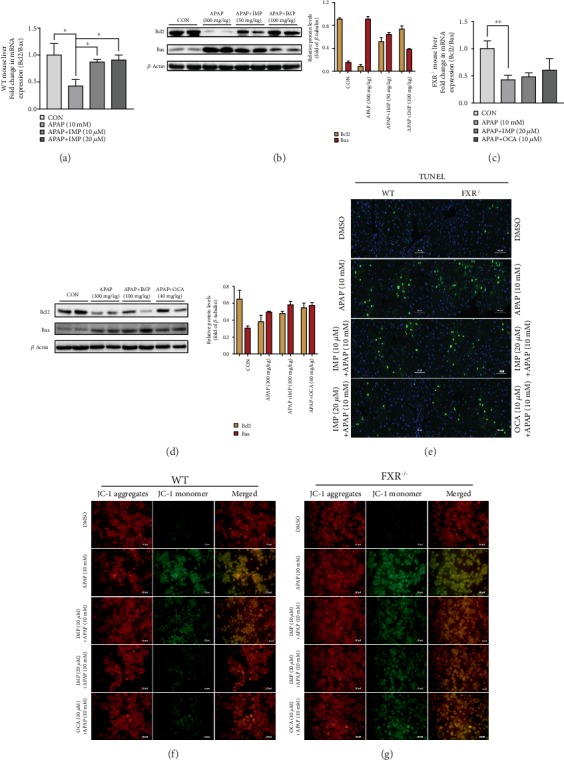
Pretreatment with IMP attenuates APAP overdose-induced apoptosis in WT mice but not in FXR−/− mice. (a, c) The mRNA ratio of Bcl2 to Bax in WT PMHs and FXR−/− PMHs. The mRNA levels of Bcl2 and Bax from cells were determined by qRT-PCR. (b, d) Proteins of Bcl2 and Bax from WT liver tissue and FXR−/− liver tissue were analyzed by Western blot. (e) The TUNEL levels in WT liver tissue and FXR−/− liver tissue after the treatment of IMP or OCA. The nucleus is stained with DAPI. (f, g) Mitochondrial membrane potential changes following the treatment of IMP or OCA. In the control group, JC-1 translocated to mitochondria through the mitochondrial membrane and aggregated into a polymer with red fluorescence. Conversely, in the APAP group, the concentration was reduced and the JC-1 polymer appeared as a green fluorescent monomer. As expected, IMP or OCA treatment decreased the green fluorescent monomer number and increased the red fluorescence polymer number. Unsurprisingly, the protective effect of IMP or OCA on mitochondrial membrane potential in FXR−/− mouse hepatocyte was not as obvious as that in WT mouse hepatocyte. Fluorescence intensity was measured by flow cytometry, and the brown fluorescence represents apoptosis. All data are expressed as the means ± SEM. Results are expressed as fold changes compared to the vehicle-treated control group; ∗p < 0.05; ∗∗p < 0.01; ∗∗∗p < 0.001. Bcl2: B-cell lymphoma 2; Bax: Bcl2-associated X protein; TUNEL: TdT-mediated dUTP nick-end labeling; DAPI: 2-(4-amidinophenyl)-6-indolecarbamidine dihydrochloride; JC-1: JC1-mitochondrial membrane potential assay to determine mitochondrial transmembrane potential; WT: wild-type mice.